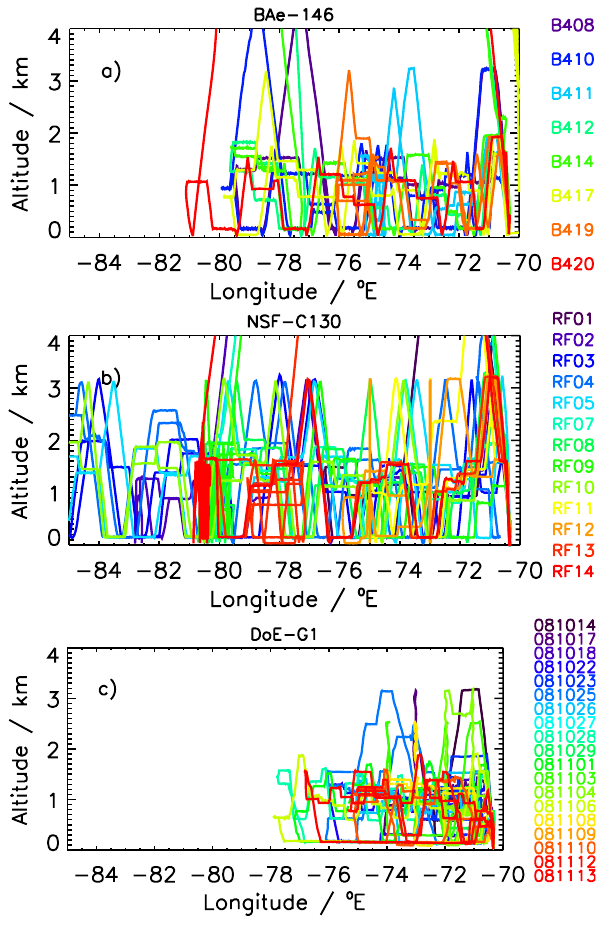
Fig. 1. Flight tracks as longitude-altitude cross-sections of VOCALS-REx flights used in this study and within 1-degree lati- tude of the 20 ◦ South parallel. Individual flight tracks are colour- coded to individual flights to illustrate sampling throughout the course of the VOCALS campaign. Each panel illustrates flight tracks from each of the aircraft platforms as